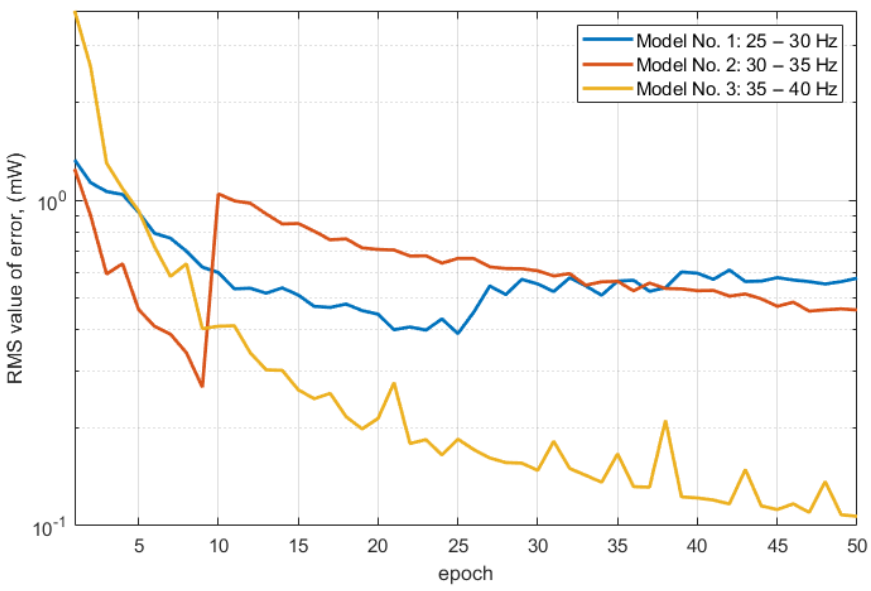
Figure 8. RMS error values 𝜀 for surrogate models vs. number of epochs.